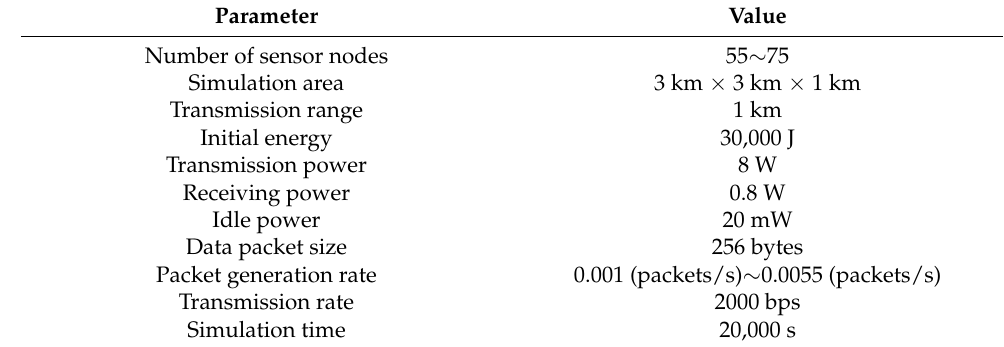
Table 1. System symbols.